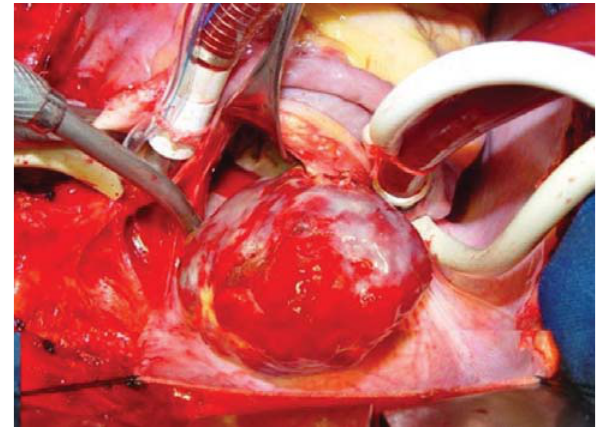
Fig. 1 - Aspecto intra-operatório da neoplasia após abertura